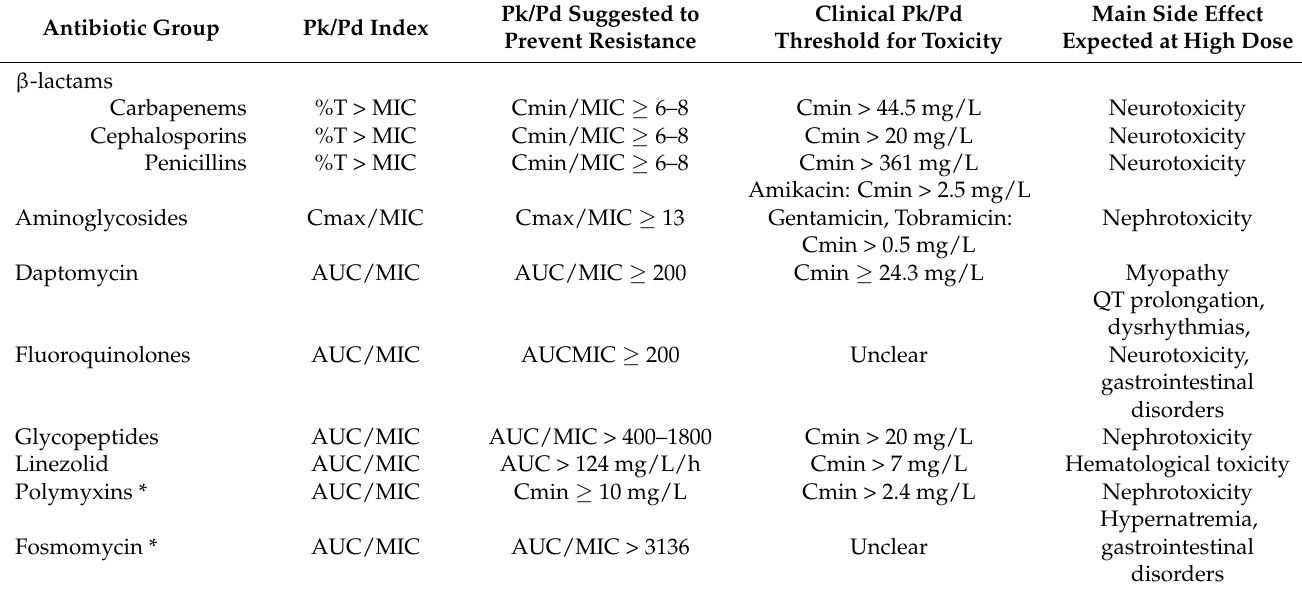
Table 2. Main pharmacokinetic/pharmacodynamic (Pk/Pd) index associated with resistance preven- tion and sides effects related with high antibiotic